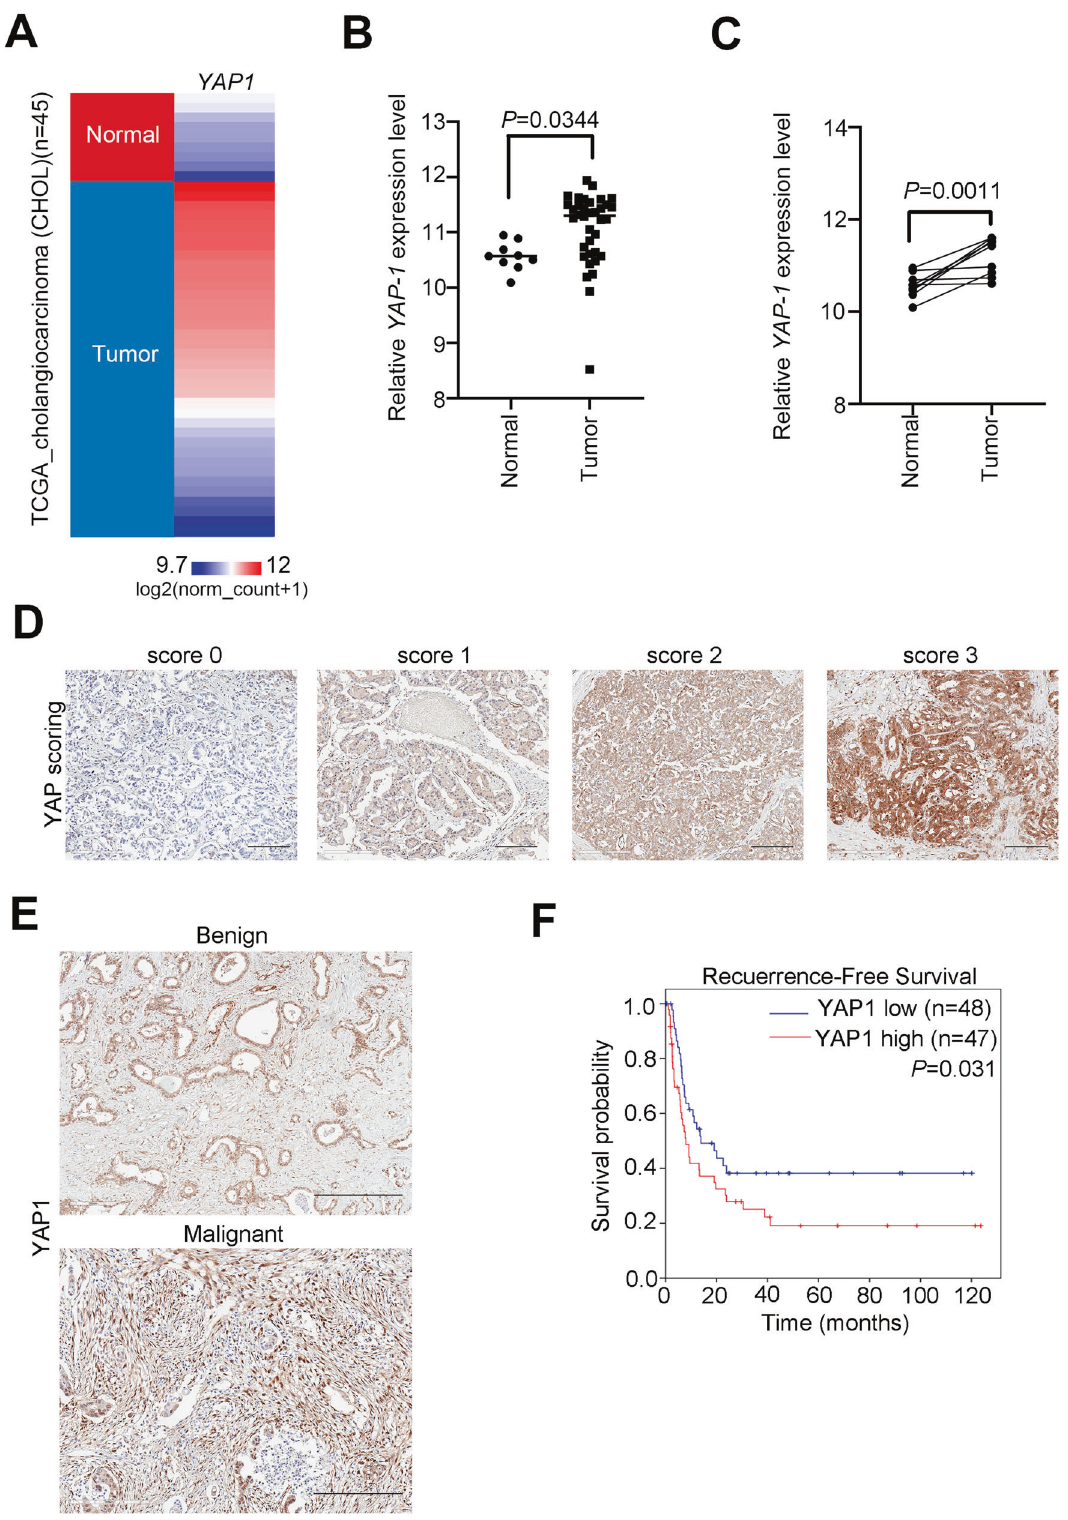
Fig. 7 YAP1 expression level correlates with poor survival and clinicopathological features in CCA patients. A Heat map of YAP1 gene expression from the TCGA RNA sequencing database in noncancerous and tumor tissues derived from CCA patients. B YAP1 gene expression from the TCGA RNA sequencing database in unpaired noncancerous and tumor tissues derived from CCA patients. C YAP1 gene expression from the TCGA RNA sequencing database in paired noncancerous and tumor tissues derived from CCA patients. D Representative IHC staining intensity of YAP1 protein in CCA tissues. Scale bar: 50 µm. E Representative IHC staining for YAP1 protein expression in benign and malignant tissues derived from patients with CCA. Scale bar: 50 µm. F Kaplan – Meier plots of recurrence-free survival of 95 CCA patients underwent hepatectomy according to YAP1 expression. The signi fi cance of the difference was determined using the nonparametric Mann – Whitney U -test.